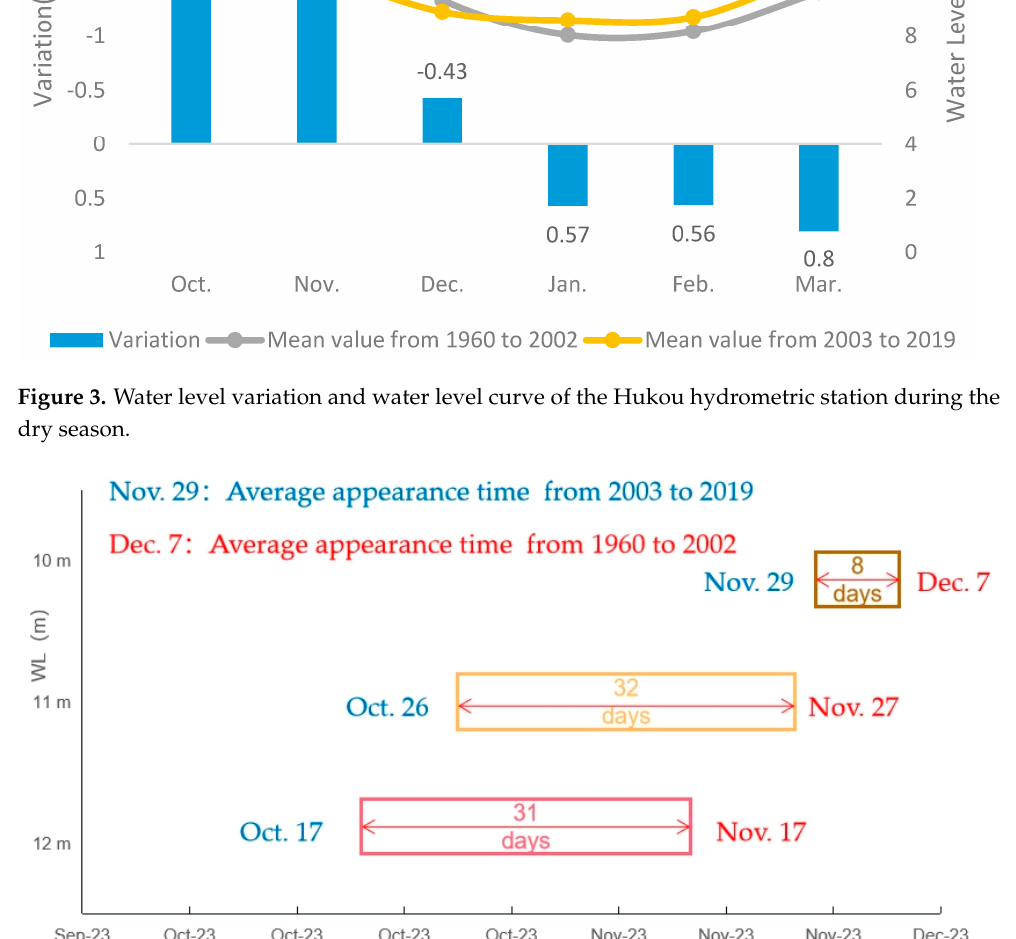
Figure 4. Comparison of average appearance times of different water levels at the Hukou hydro- metric station before and after operation of the Three Gorges Project.